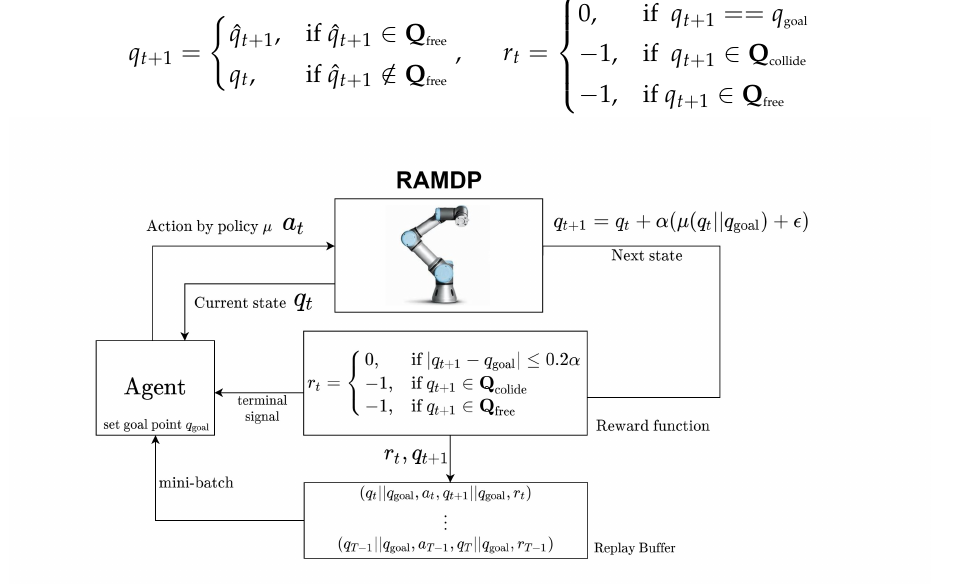
Figure 1. Robot Arm Markov Decision Process